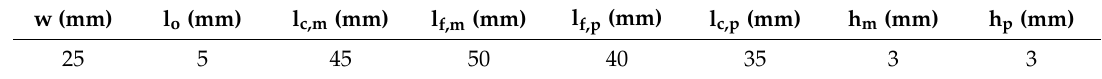
Table 2. Geometrical parameters of the lap shear specimens.